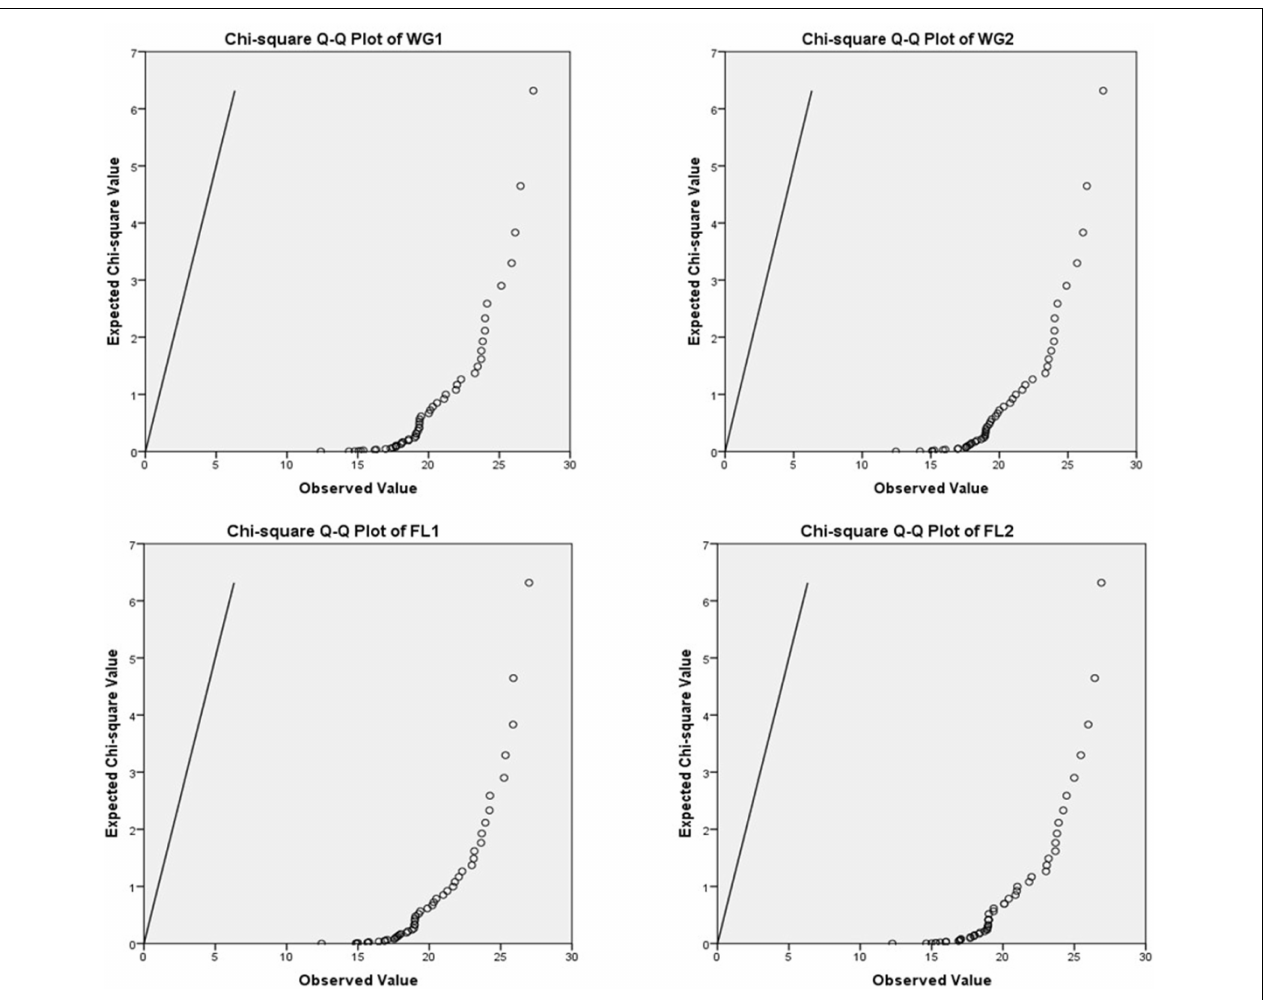
FIGURE 4 | Chi-square Q-Q plots of WG1, WG2, FL1, and